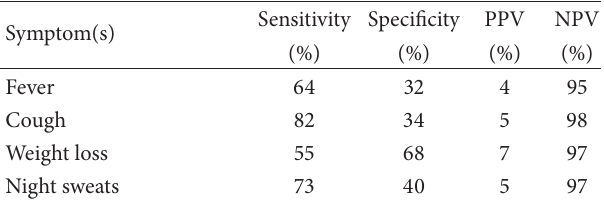
Table 2: Predicting pulmonary tuberculosis based on the existence of individual clinical symptoms in Gondar, North West Ethiopia, 2012.